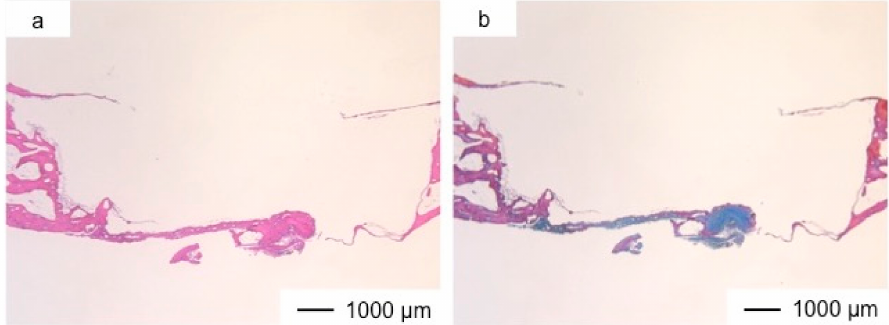
Figure 2. Light microscopic images of the commercial bone cement in cranioplasty at three years postoperatively stained by hematoxyline–eosine (HE) ( a ) and Light microscopic images of the commercial bone cement in cranioplasty at three years postoperatively stained by Azan-Mallory (AM) method ( b